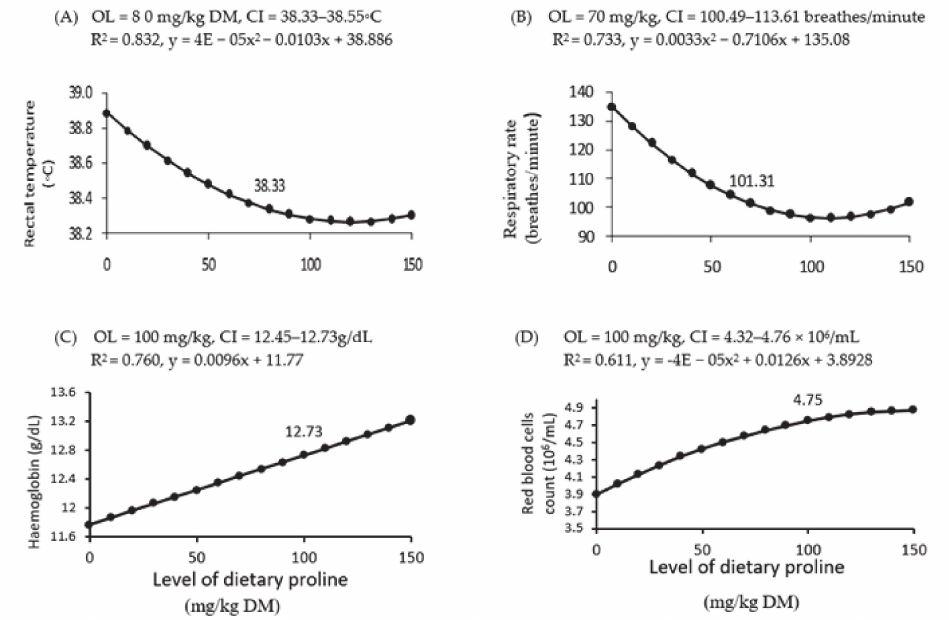
Figure 2. Dose–response curve of rectal temperature ( A ), respiratory rate ( B ), haemoglobin concentration ( C ), and red blood cell counts ( D ) for different levels of dietary supplemental proline. DM = dry matter, OL = optimum level of dietary supplemental proline and CI = confidence interval. R 2 = regression value, and x and y are the dependent variable (proline level) and the independent variable of the regression equation, respectively. The figure only shows significant ( p < 0.05)